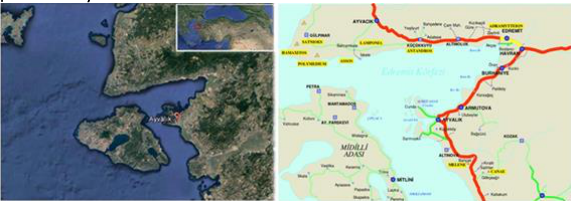
Figure 1 : Location of Ayvalık (Google Earth, last accessed on September 12, 2016) and its close environment